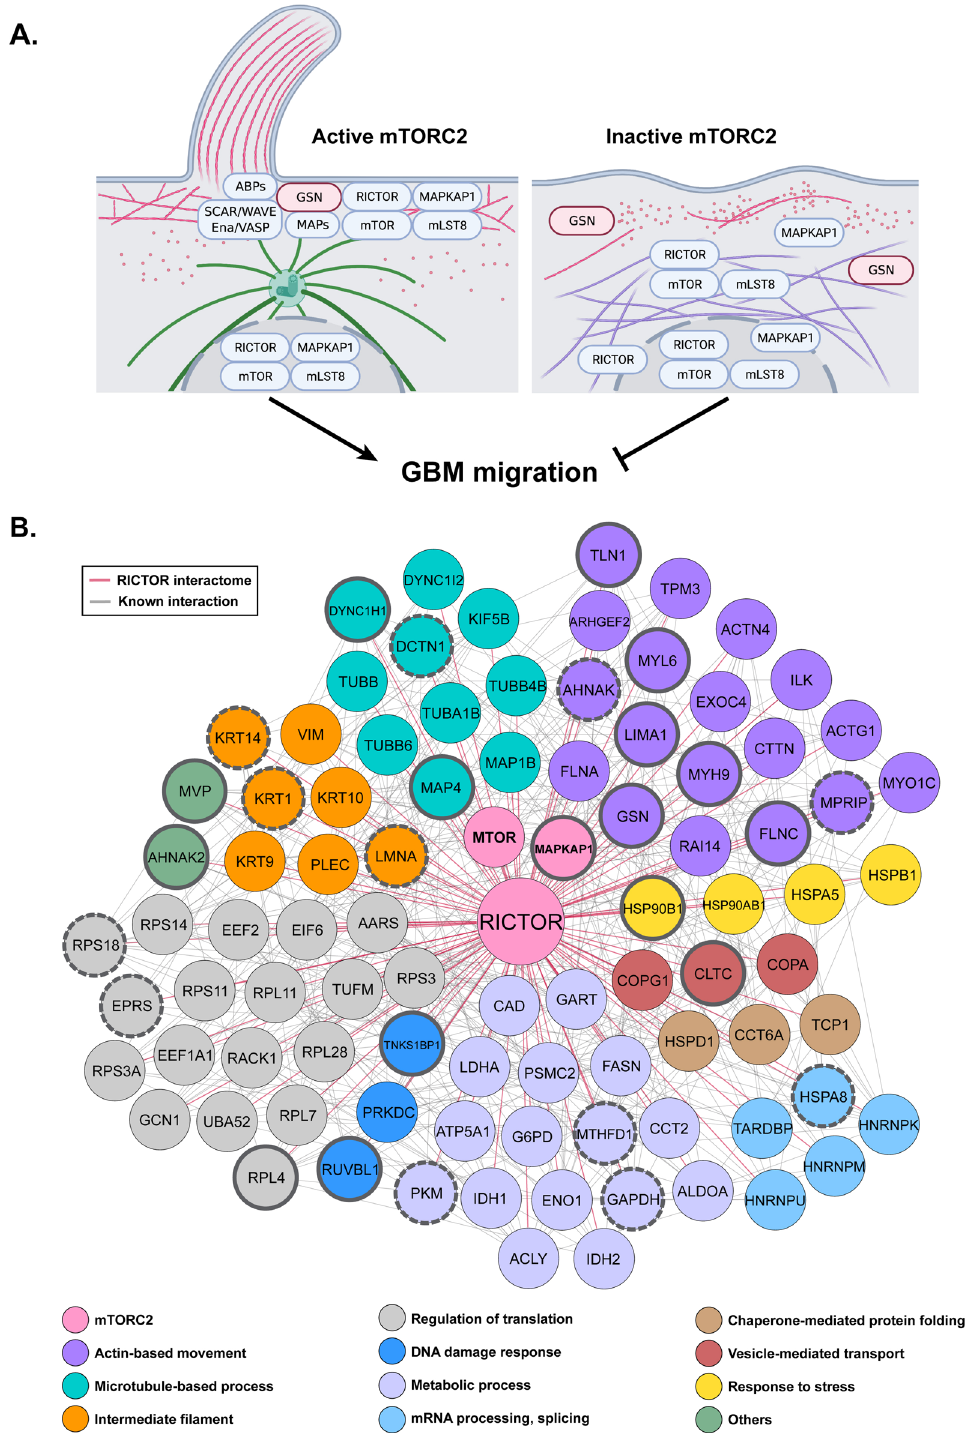
Figure 7. Roles of the mTORC2 interactome in cell migrational control and others. (A) Diagram of the active mTORC2 function in controlling glioblastoma cell migration via RICTOR-GSN interaction by recruiting actin-binding proteins and microtubule-associated proteins to form cell protrusion structures (left). Under inactivation conditions, mTORC2 loses MAPKAP1 and interacts with intermediate filament proteins (right). (red: actin cytoskeleton, green: microtubule, purple: intermediate filaments). The graphic was created by Biorender.com. (B) Diagram showing the final 86 mTORC2 stable interactomes commonly identified from all methods. Proteins were categorized into groups depending on their primary functions and associated biological processes. Pink lines indicate novel interactions. Circles with bold borders represent the dynamic mTORC2 interactome upregulated (solid line) or downregulated (dashed line) in migrating glioblastoma